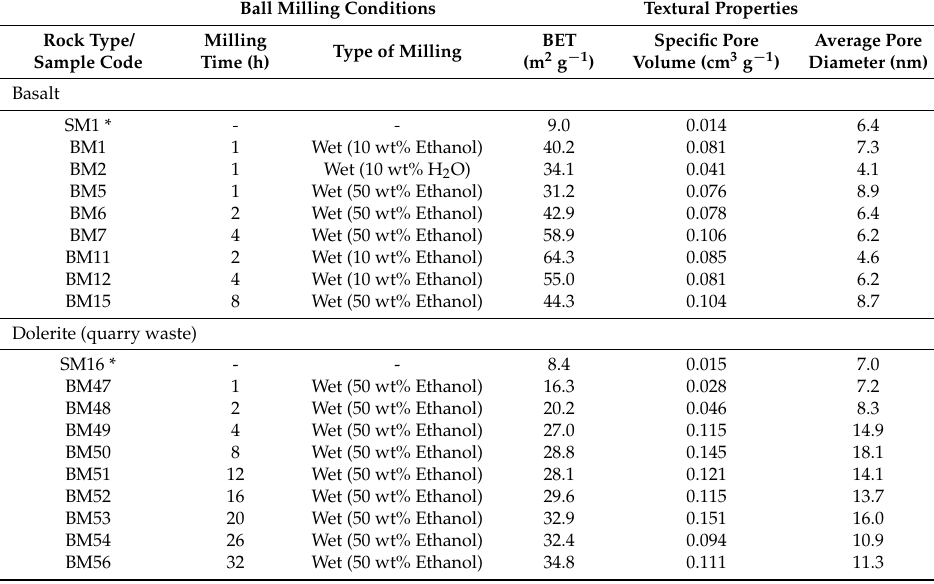
Table 2. Ball milling conditions and textural properties of the unmilled and ball-milled mafic rocks (data from Rigopoulos et al.